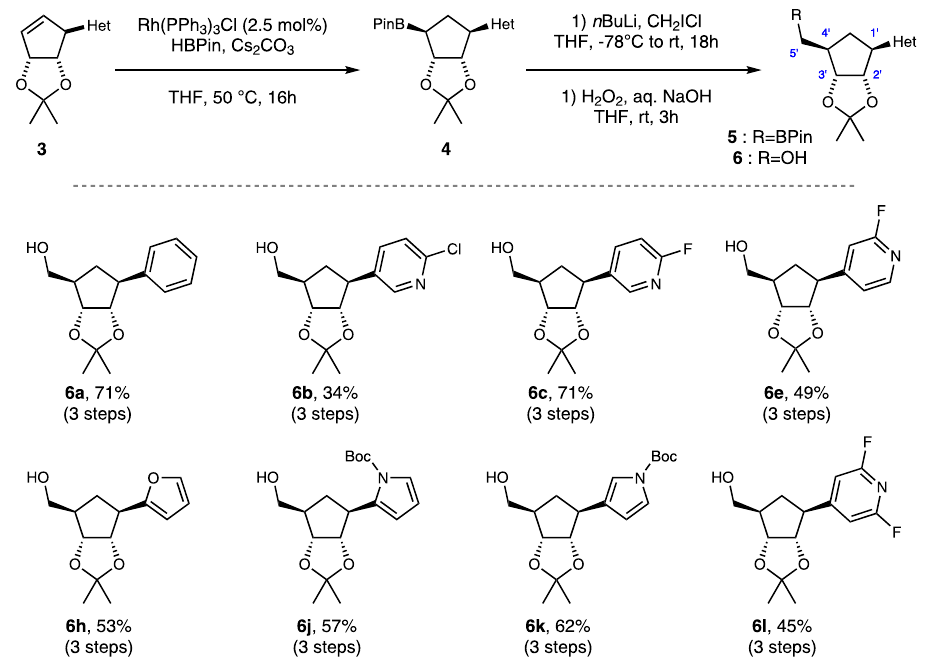
Fig. 5 Hydroborylation and homologation of cyclopentenes 3. Elaboration of cyclopentenes 3 to RNA analogs. Reaction Conditions - Hydroborylation: 3 (1